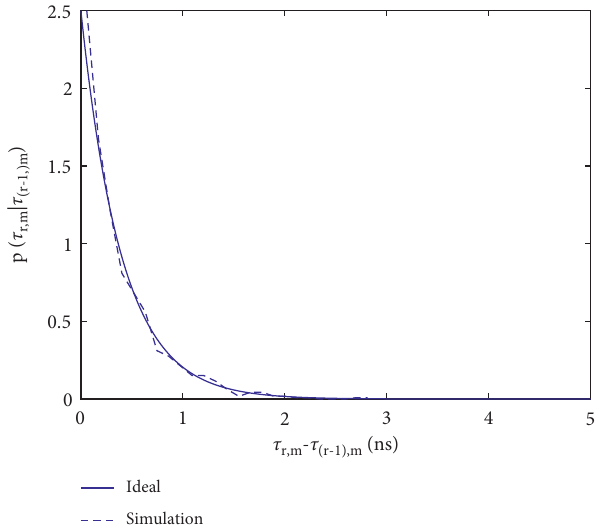
Figure 7: Time distribution of cluster arrival in the S–V model.